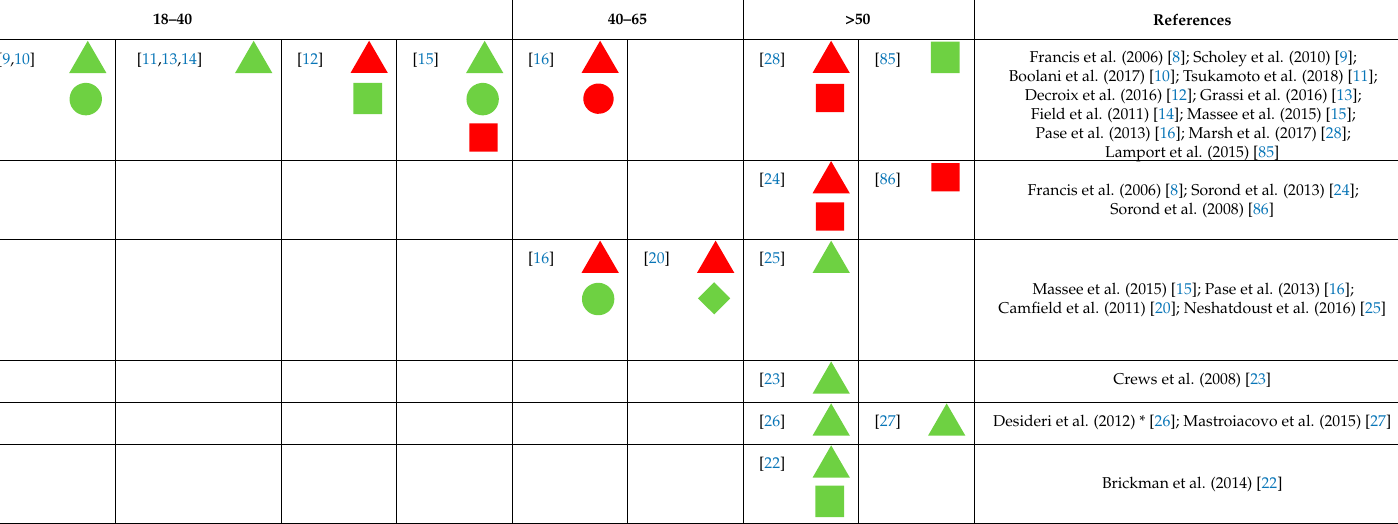
Triangle = cognition; circle = mood; square = cerebral blood flow; diamond = steady-state visually evoked potential. Green = positive effect; red = no or negative effect. * = Mild cognitive